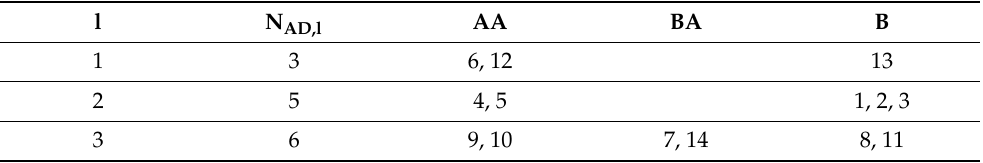
Table 7. Dominance areas in the considered power